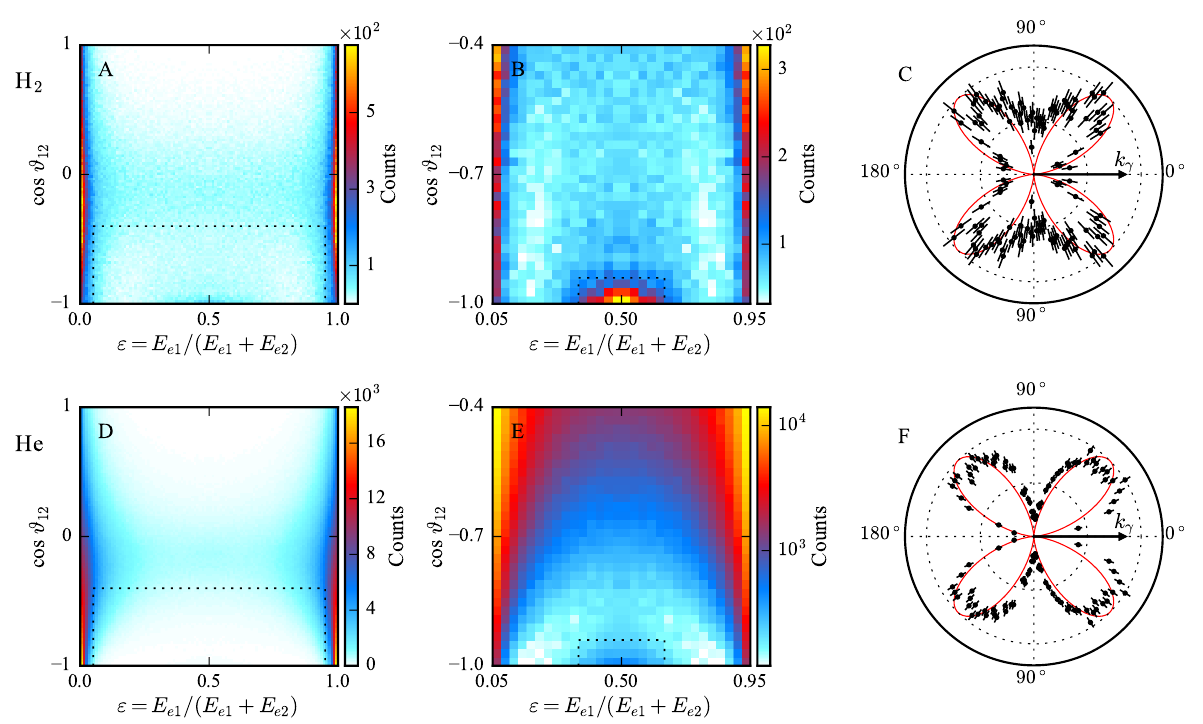
Figure 2. Measured electron distributions of H 2 double ionization ( A – C ) and He double ionization ( D – F ) by a single 800 eV circularly polarized photon. ( A , D ) Measured electron yield as a function of the electron energy sharing ε and the electron mutual angle ϑ 12 . ( B , E ) Detailed section from panels A and D as indicated by the dashed black lines therein. Note the logarithmic-scale display in panel E. Contributions around ε = 0.5 and cos ϑ 12 = − 1 correspond to the QFM electrons. ( C , F ) Angular distributions of QFM electrons as a function of the polar angle enclosed by the electron momentum vector and the light propagation direction. The shown data are limited to 0.35 < ε < 0.65 and ϑ 12 > 160 ◦ , as indicated by the dashed black lines in panels B and E. For this selection, the dipole contribution to photoionization vanishes. The red lines represent | Y 21 | 2 and are normalized to the data